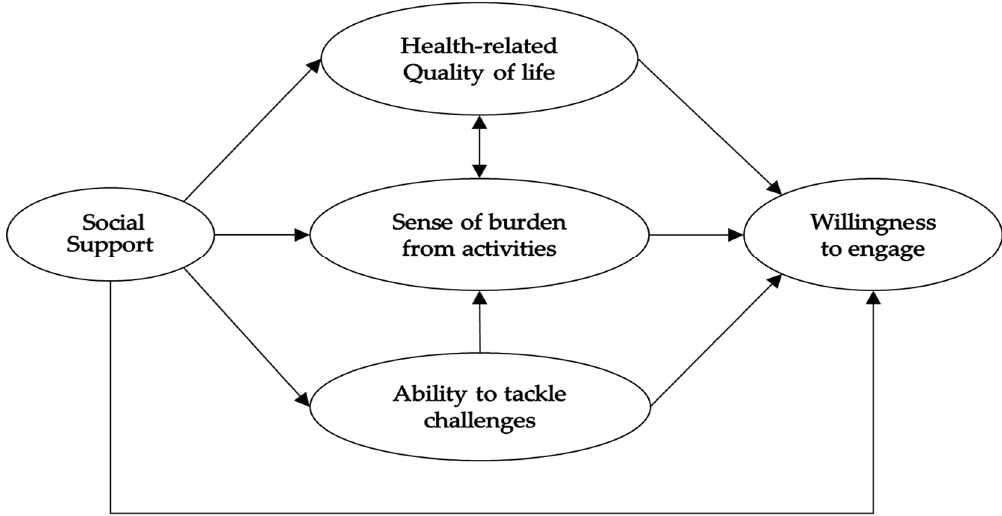
Figure 1. Analytical model.